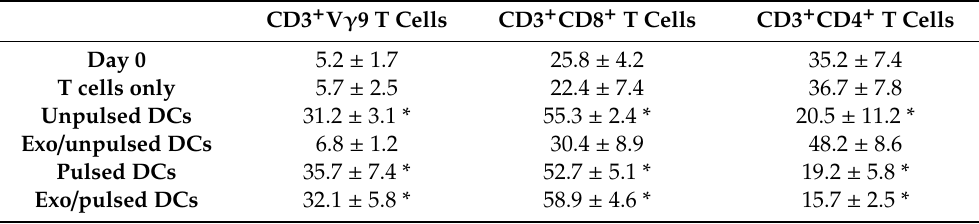
Table 1. Incubation of DCs and their exosomes with T cells increased the proportions (%) of CD3 + V γ 9 T cells, CD3 + CD8 + T cells, and CD3 + CD4 + T